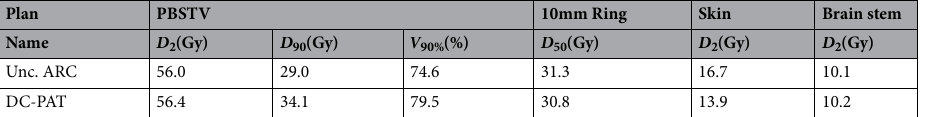
Table 3. DVH coverage metrics following a treatment plan with and without DCS collimation that prioritized a maximum brain stem dose goal.